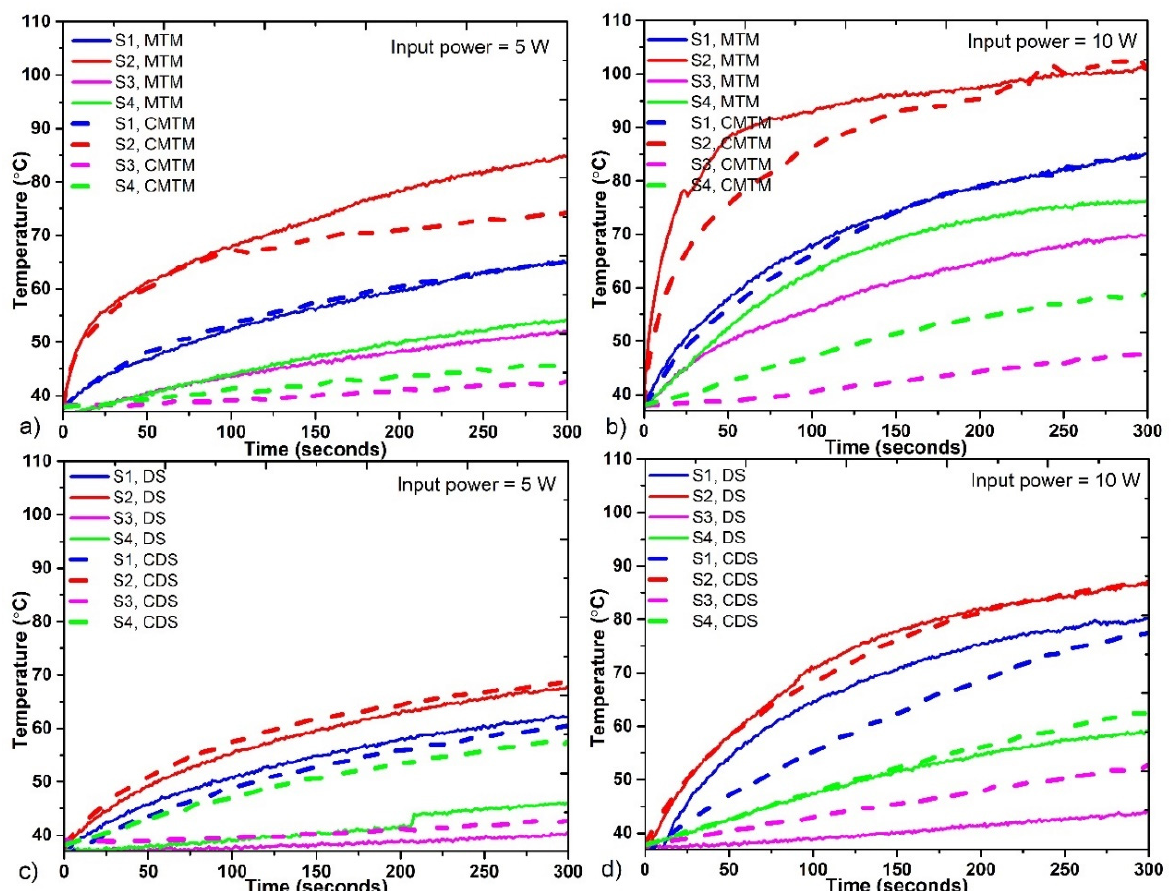
Figure 6. Temperature profiles reached by each antenna during the experiments. ( a ) Comparison between the MTM and the CMTM antennas fed with 5 W, ( b ) Comparison between the MTM and the CMTM antennas fed with 10 W, ( c ) Comparison between the DS and the CDS antennas fed with 5 W, ( d ) Comparison between the DS and the CDS antennas fed with 10 W.